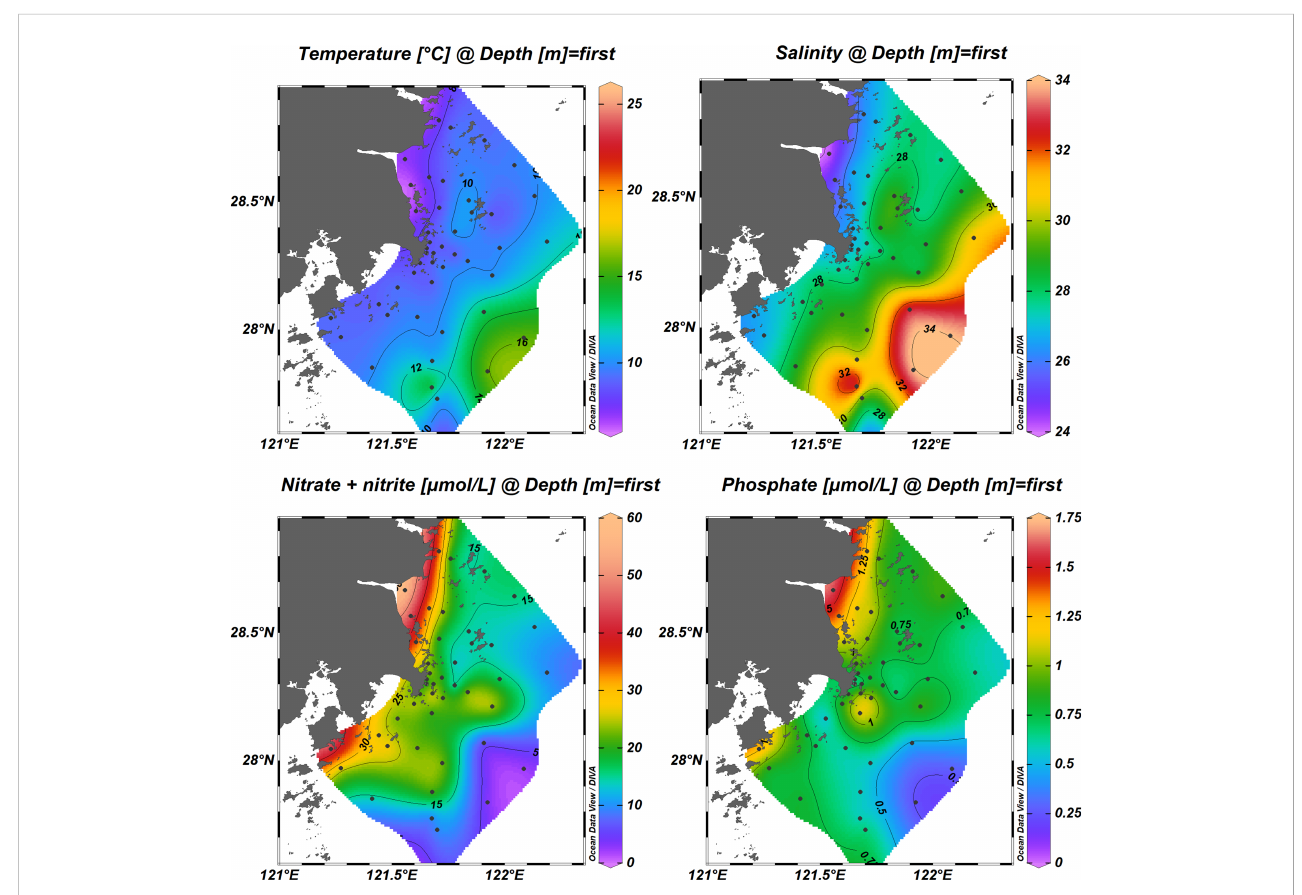
FIGURE 6 Distribution of temperature, salinity, phosphate, and nitrate + nitrite in the surface seawater from Wenling, Zhejiang Province. The fi gure was created with Ocean Date View software (Schlitzer,